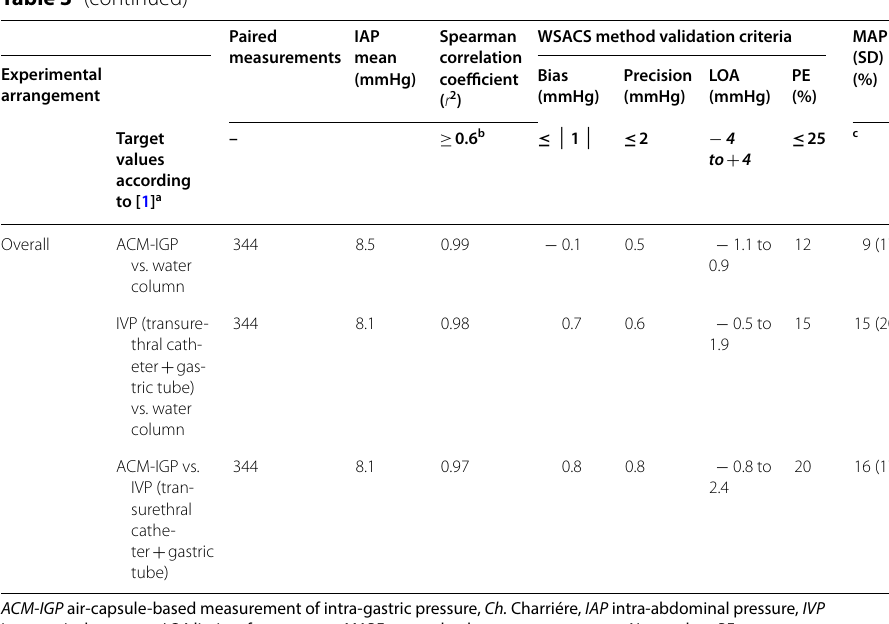
(Fig. 2b–d, Table 3). Pressures obtained by ACM-IGP and IVP agreed well ( r 2 0.97, mean bias precision 0.8 0.8 mmHg, LOA 0.8 to 2.4 mmHg, PE 20%, MAPE 15 ± ± −